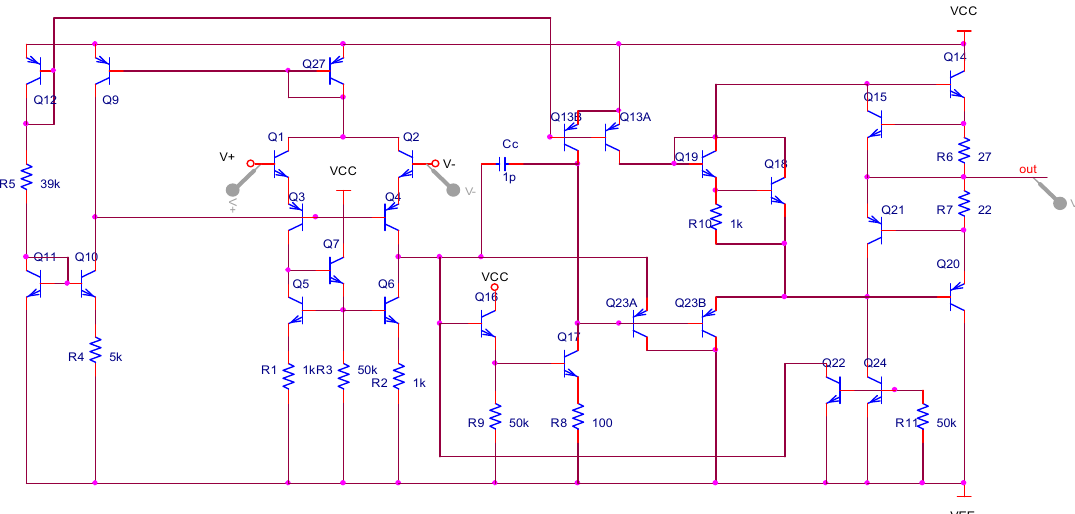
Figure 10. Basic structure of the interface ASIC circuit.